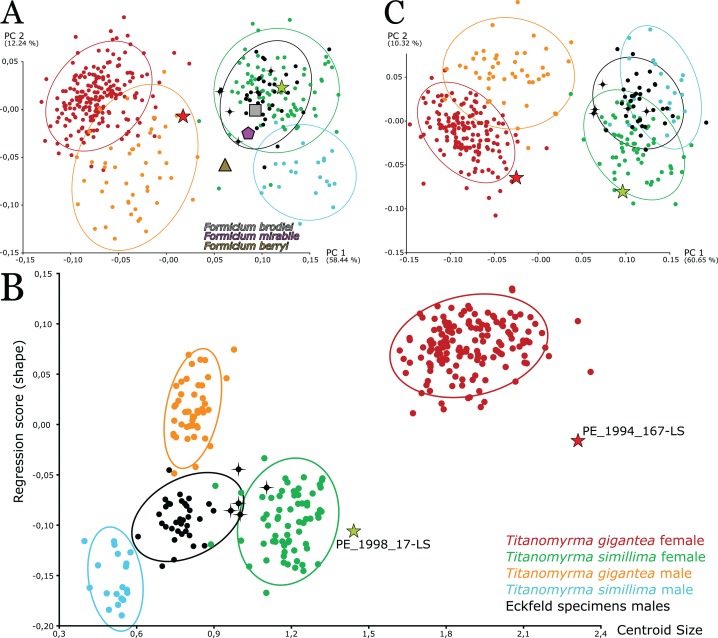
Shape and size variation among Titanomyrma and Formicium specimens.(A–C) Five larger Eckfeld males are highlighted with crosses. (A) A PCA of all specimens reveals close shape associations between Eckfeld specimens, T. simillima females, F. brodiei, and F. mirabile. F. berryi appears in an intermediate position. The overall pattern resembles the PCA of the Messel specimens (Fig. 2A). The analysis was performed in SD 9. (B, C) The analyses were performed in SD 10. (B) The independent variable Centroid Size is regressed over the dependent shape variable. T. gigantea is distinct in shape, signified by a higher Regression score. Eckfeld males and T. gigantea males have a similar size range. There is also a size overlap between Eckfeld males and T. simillima females. (C) A PCA including all specimens with scaling information, grouped after classifiers locality, species, and sex. This PCA was performed with the residuals of an attempt to correct for size by pooled-within-group regression of shape over centroid size. Most of the variation is still between T. gigantea and the others. Female and male specimens cluster apart from each other in PC 2.